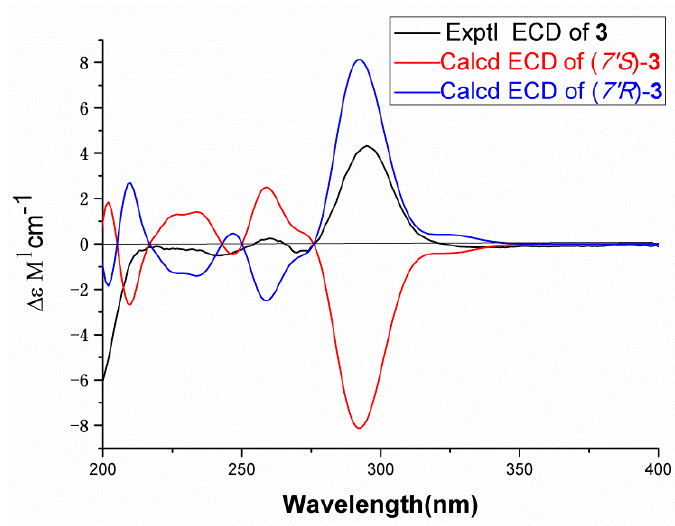
Figure 4. The ECD spectrum of compound 3.